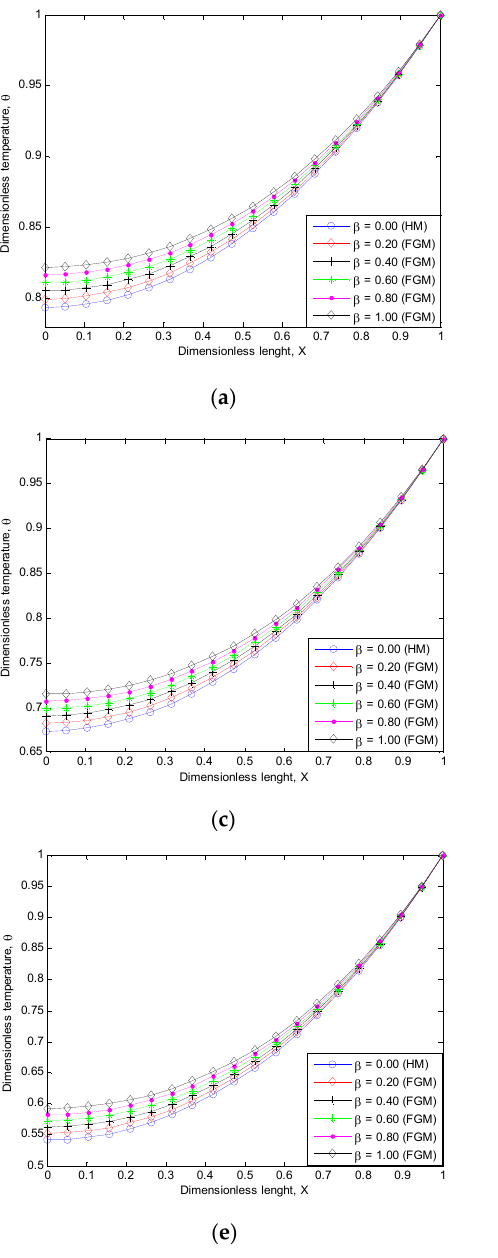
Figure 3. Fin dimensionless temperature profile for varying thermo-geometric parameter under linear-law function when: ( a ) Nc = 0.5, Ra = 0.01, Nr = 0.0; ( b ) Nc = 0.1, Ra = 0.01, Nr = 0.2; ( c ) Nc = 0.1, Ra = 0.01, Nr = 0.4; ( d ) Nc = 0.2, Ra = 0.01, Nr = 0.3; ( e ) Nc = 0.5, Ra = 0.01, Nr = 0.2; and ( f ) Nr = 0.2, Ra = 0.01, Nr = 1.0.